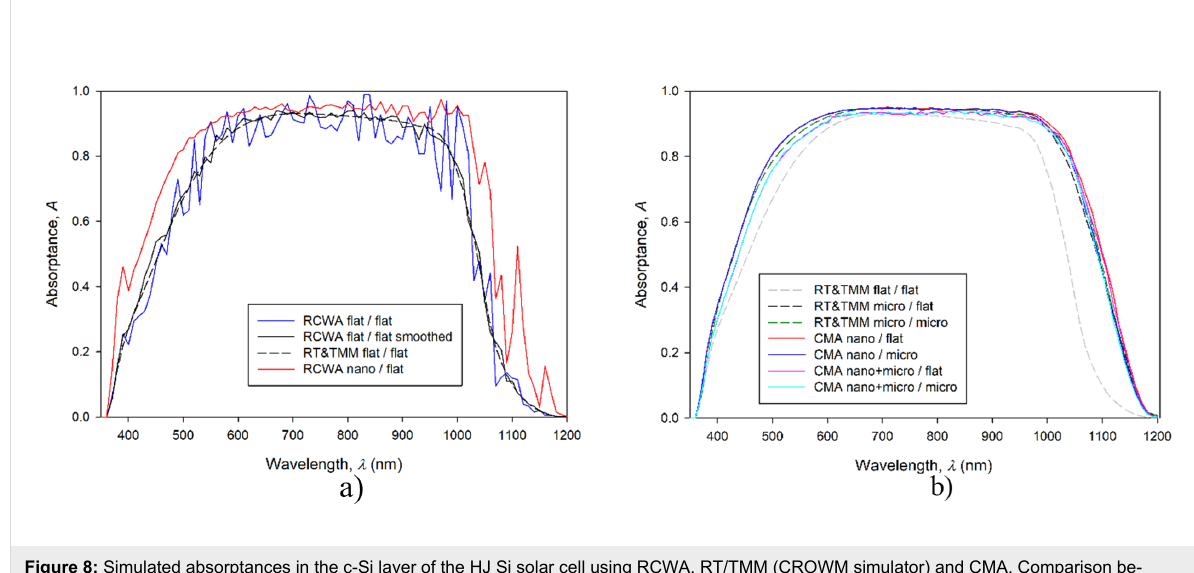
Figure 8: Simulated absorptances in the c-Si layer of the HJ Si solar cell using RCWA, RT/TMM (CROWM simulator) and CMA. Comparison be- tween RCWA and RT/TMM is shown in (a). (b) RT/TMM and CMA simulations of the solar cell with a nanotexture with PF 1. Corresponding J SC values calculated from the absorptance curves are listed in Table 2.